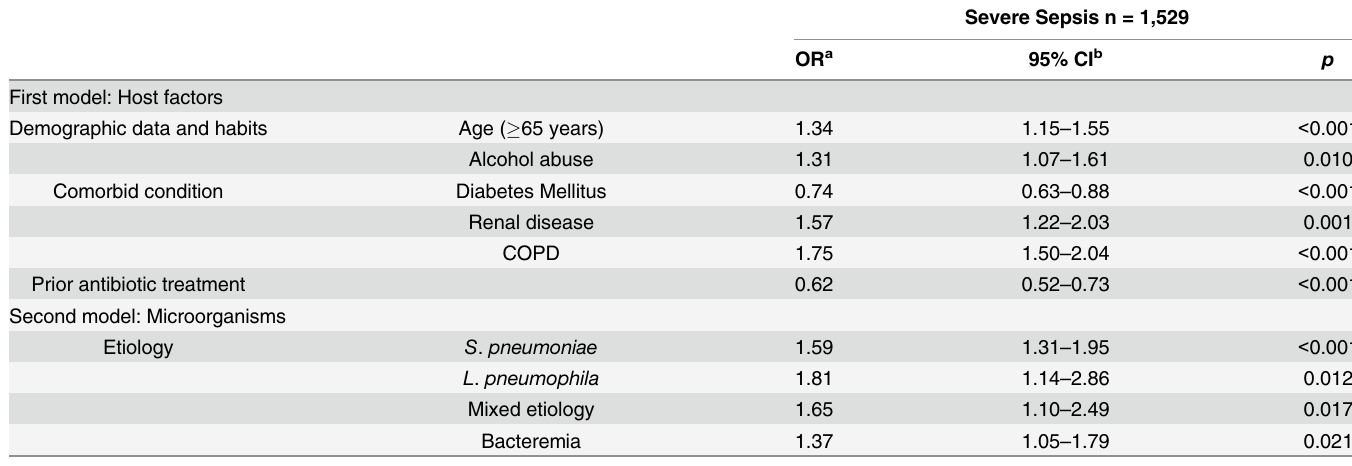
Table 4. Multivariable analysis results of severe sepsis related to host factors (first model) and microorganisms (second